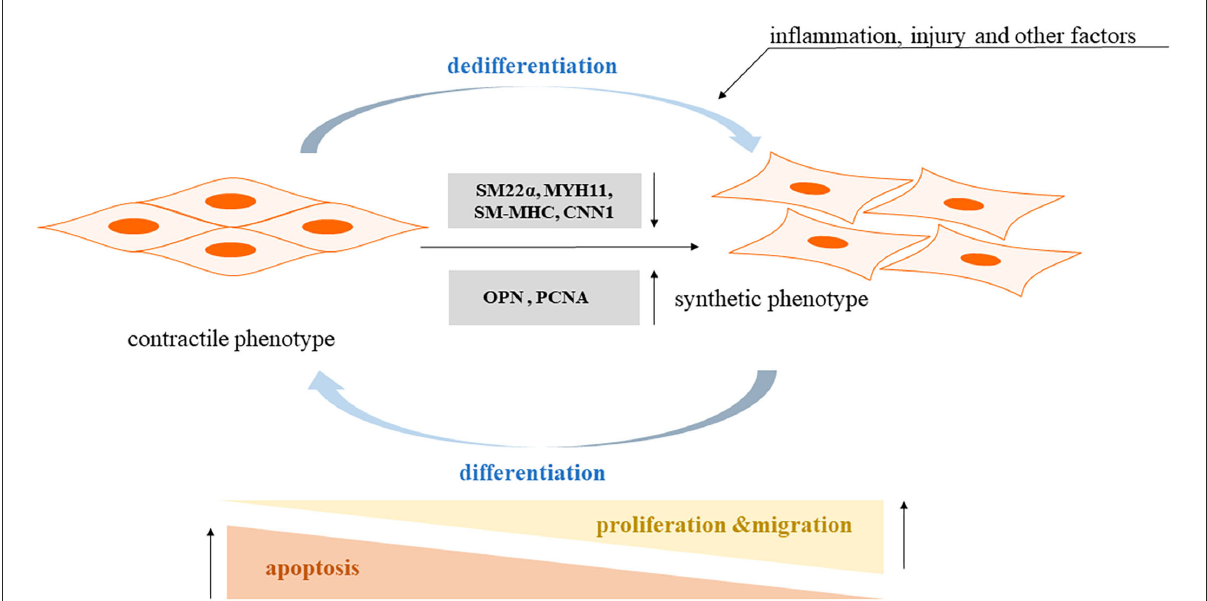
FIGURE1 The pathophysiological mechanism of smooth muscle cells phenotypic transformation. Contractile phenotype markers: SM22a: smooth muscle 22a; SM-MHC: smooth muscle myosin heavy chain; MYH11: myosin heavy chain 11; CNN1: calponin 1. Synthetic phenotype markers: OPN: osteopontin; PCNA: proliferating cell nuclear